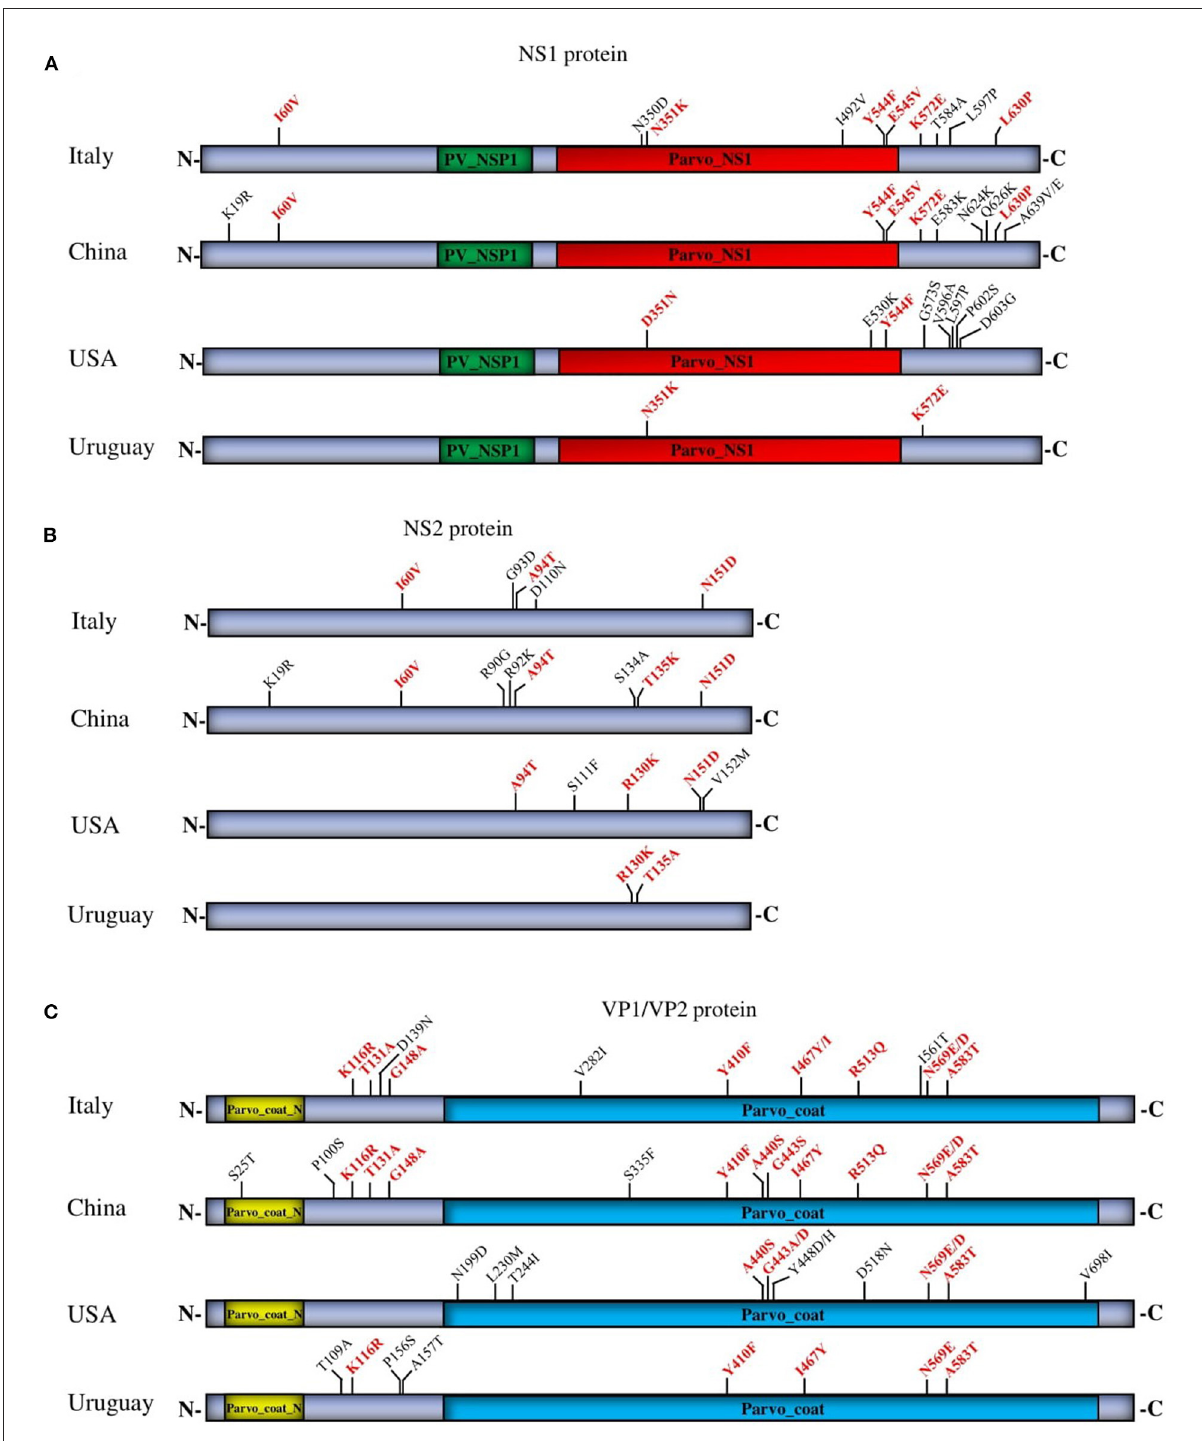
FIGURE5 Parsimony analysis of NS1 (A) , NS2 (B) , and VP1/VP2 (C) proteins of circulating CPV-2 strains from four countries (China, Italy, the USA, and Uruguay). The common and unique PI sites are indicated in red and black letters and numbers, respectively.